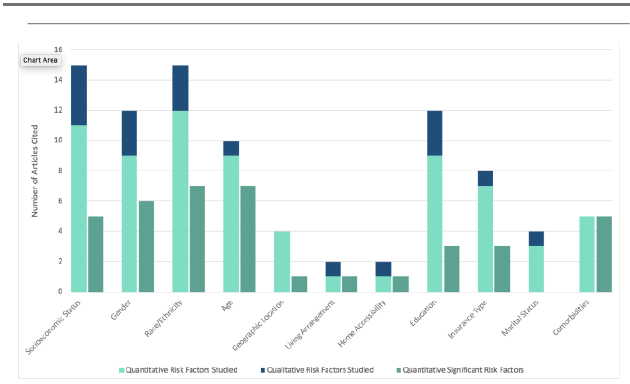
Figure 3. Commonly cited risk factors potentially resulting in healthcare disparity evaluated in current literature 3-5, 8-11,13-14,16-